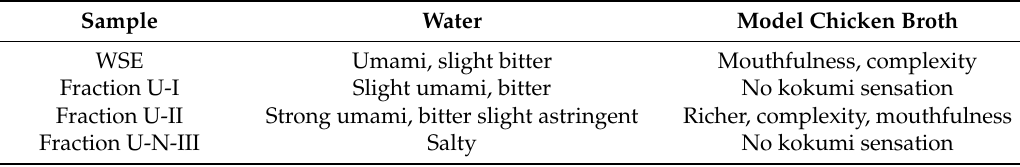
Table 1. Sensory evaluation of water-soluble extract (WSE), ultrafiltration, and nanofiltration fractions in both water and model chicken